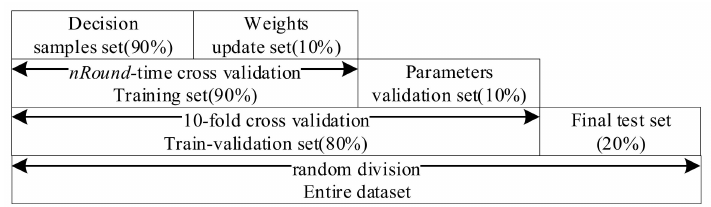
Figure 3. Dataset division in